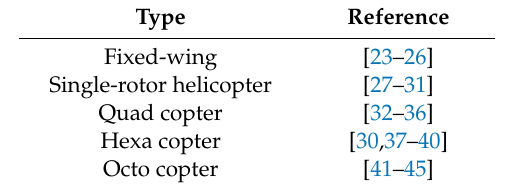
Table 2. Different types of RPAS (remotely piloted aircraft system) models developed in past studies for precision agriculture.